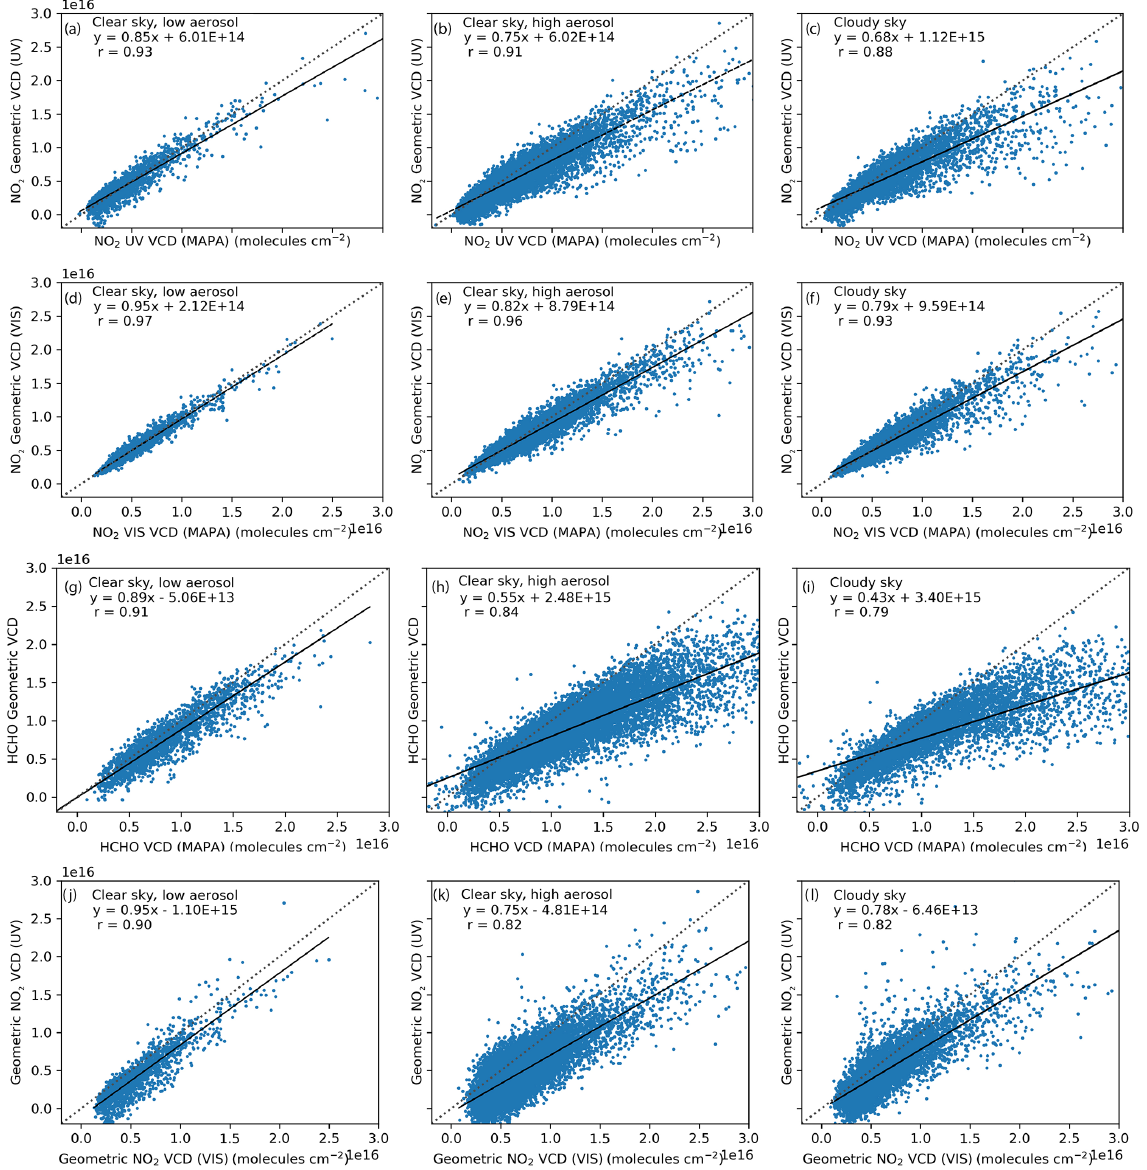
Figure A3. Comparison of VCDs calculated using the geometric approximation at 15 ◦ elevation angle and that calculated using MAPA for NO 2 in the UV (top row), NO 2 in the visible (second row), and HCHO (third row) for various sky conditions: clear sky with low aerosol load (left), clear sky with high aerosol load (middle), and cloudy-sky conditions except for thick clouds and fog (right). The bottom row shows the comparison of NO 2 VCD calculated using the geometric approximation for spectral analyses in the UV and visible for the three different sky